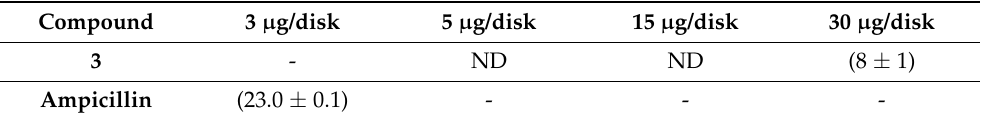
Figure 4. Disk test diffusion method of antibacterial activity of imidazole 3 against S. aureus ATCC 6538: ( A ) with 10 µL of DMSO, ( B ) 5 µg/disk, ( C ) 15 µg/disk and ( D ) 30 μg/disk. Table 1. Inhibition halos and standard deviation of imidazole derivative 3 against S. aureus ATCC 6538 in the disk diffusion assay.